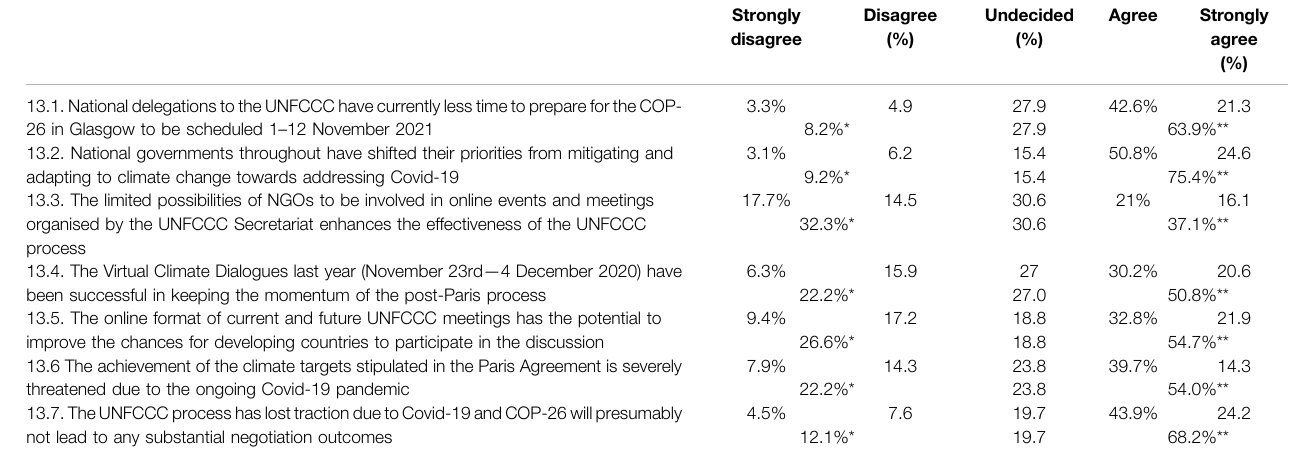
TABLE 2 | summarizes the responses regarding the evolution of the UNFCCC process.